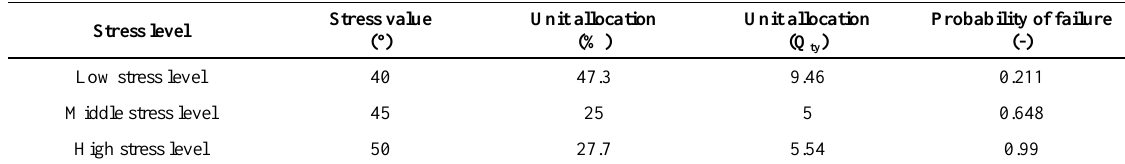
Table 1. Recommended test plan